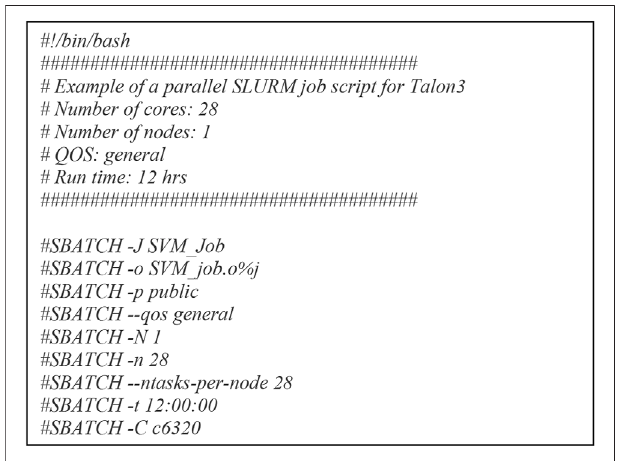
FIGURE 6 | Shell script for parallel